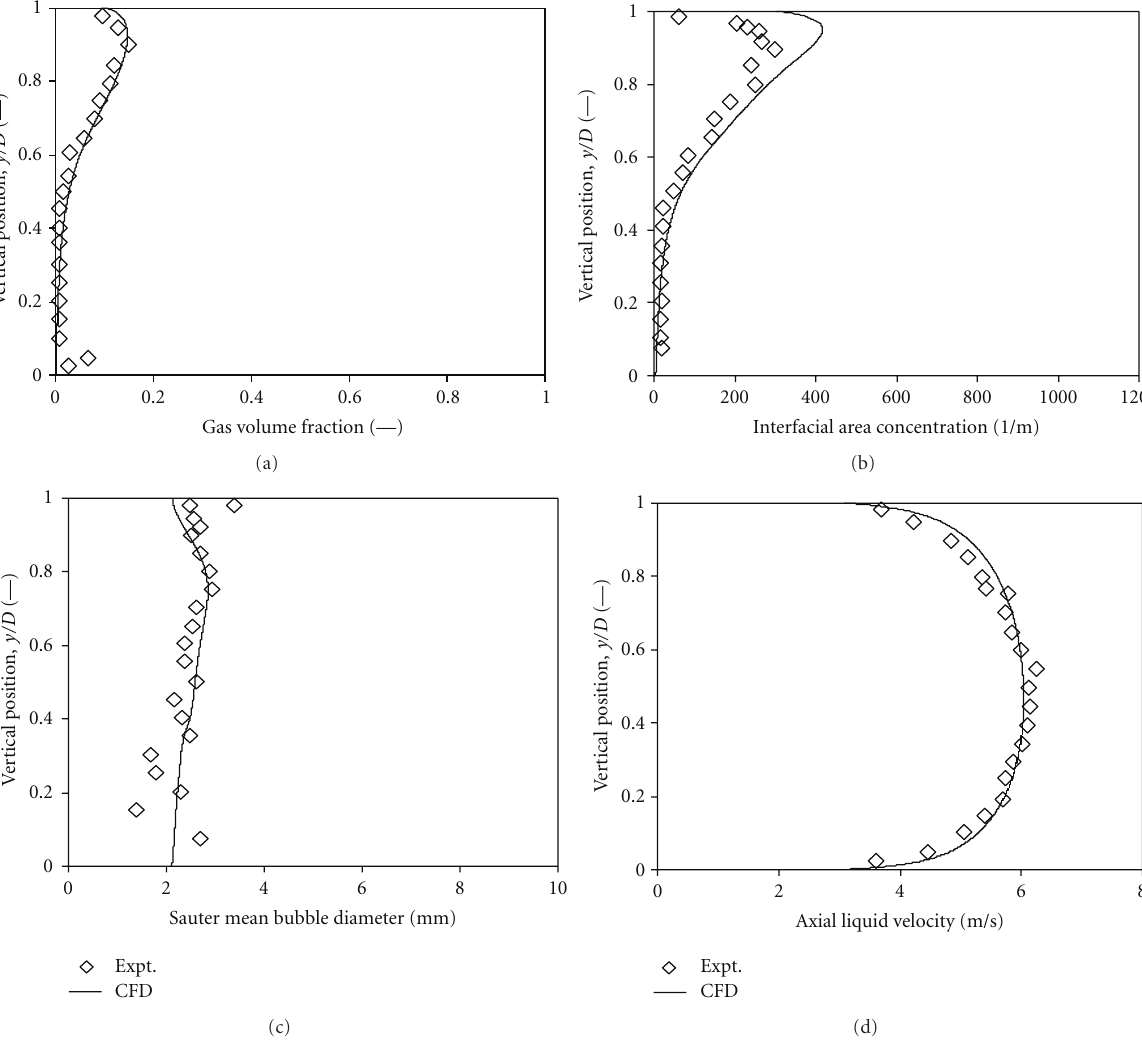
Figure 3: Comparison of predicted and experimental data of Kocamustafaogullari and Wang [17] for superficial gas velocity of 0.25 m/s, superficial liquid velocity of 5.1 m/s, and volume fraction 0.043: (a) gas volume fraction, (b) interfacial area concentration, (c) Sauter mean bubble diameter, and (d) axial liquid